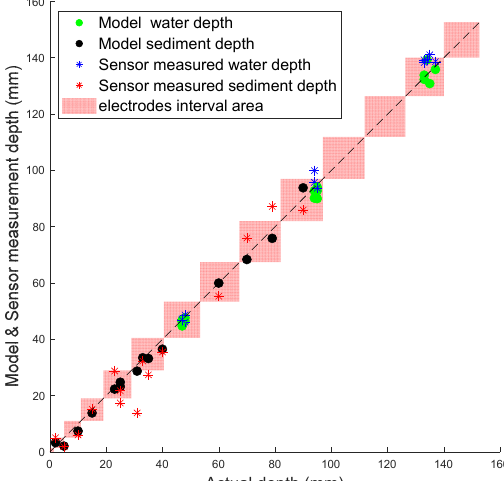
Figure 10. Model and sensor measured results with acceptance range.